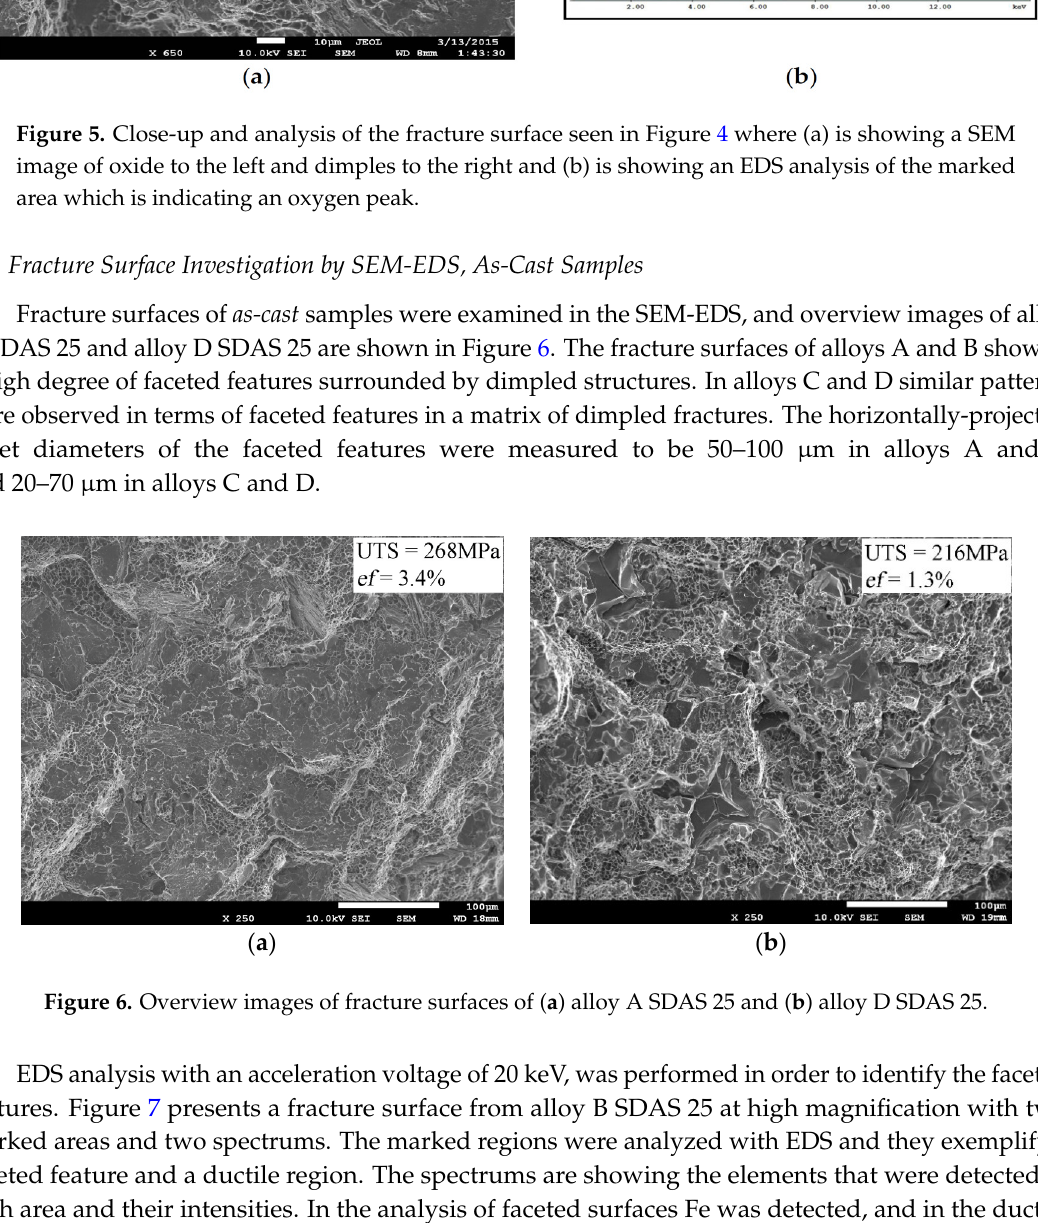
Figure 5. Close ‐ up and analysis of the fracture surface seen in Figure 4 where ( a ) is showing a SEM Figure 5. Close-up and analysis of the fracture surface seen in Figure 4 where (a) is showing a SEM